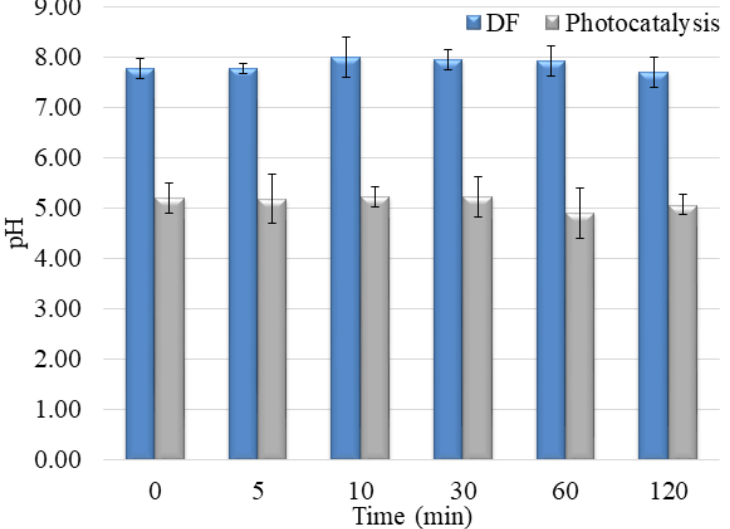
Figure 13. pH values during NAD, PIN, and MET mixture degradation under UV irradiation without/with V 2 O 5 catalyst.